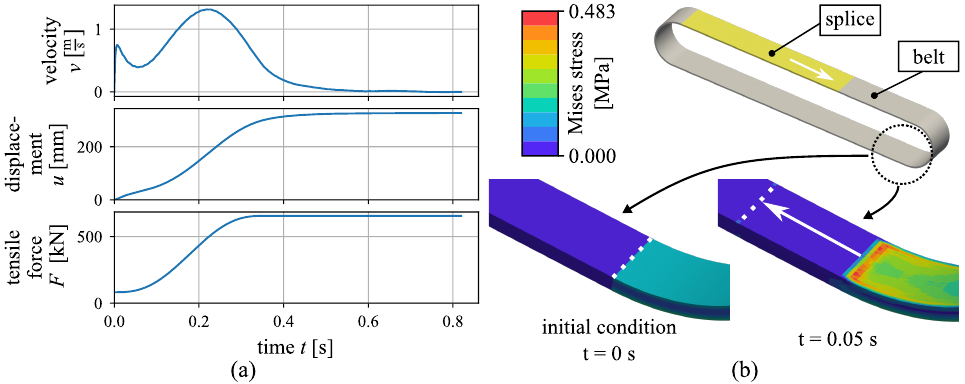
Figure 9. ( a ) Evolution of velocity, displacement, and tensile force in the x-direction of the refer- ence point P and ( b ) validation of the applied residual stress in the initially bent regions of the conveyor